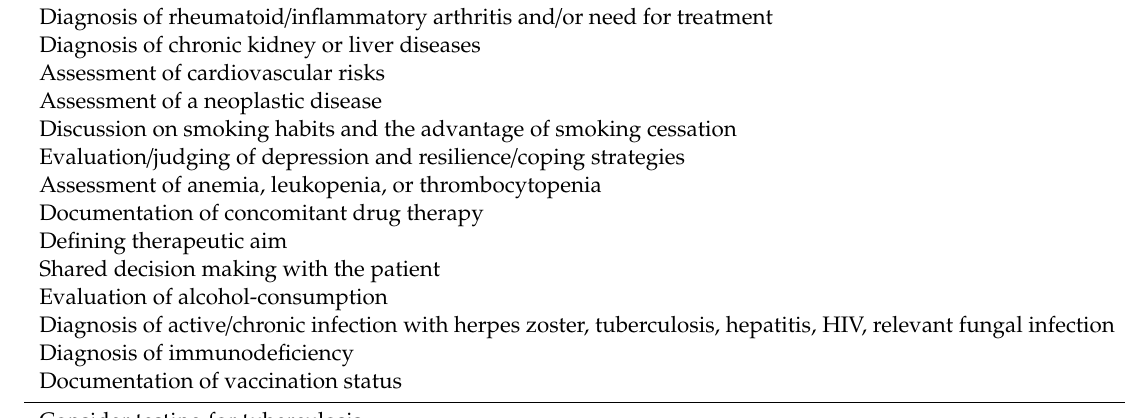
Table 2. Preparation of MTX